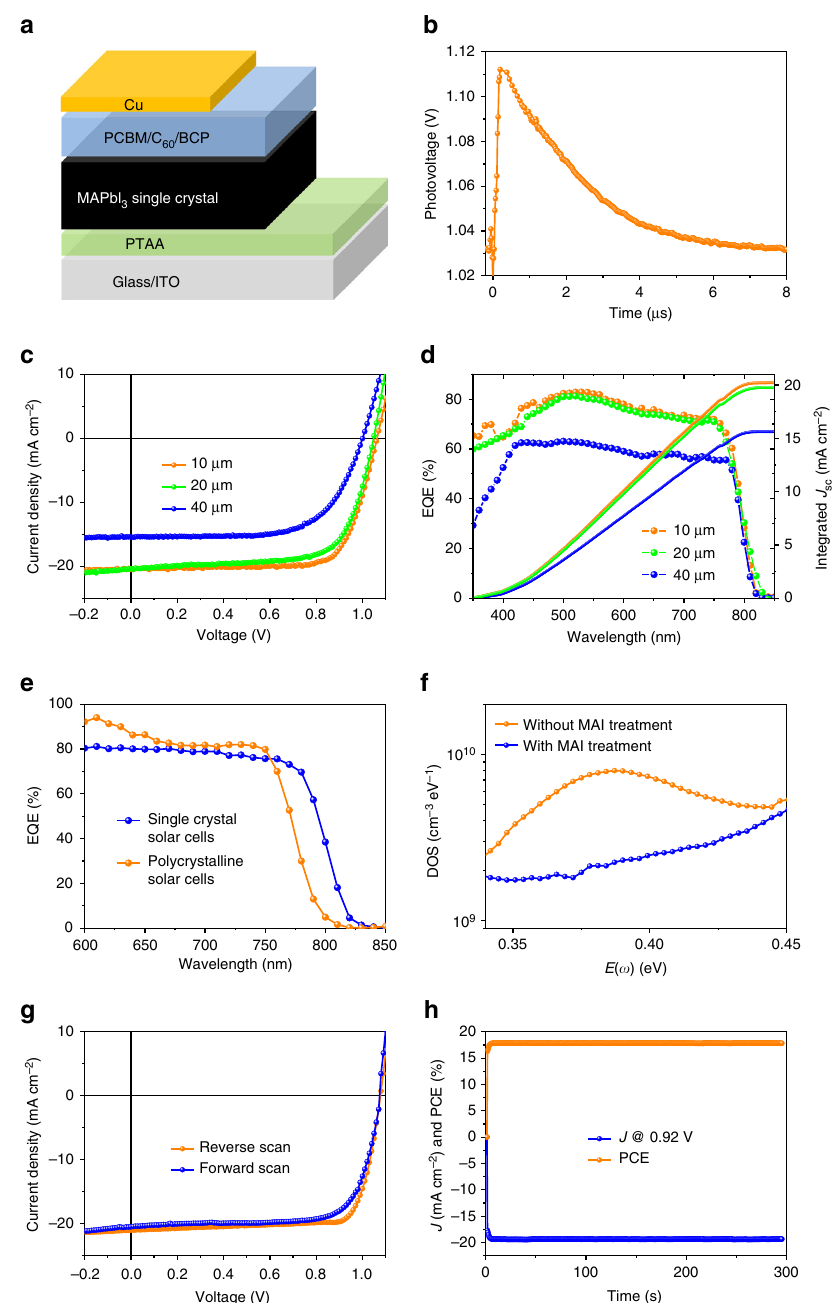
Fig. 4 Characterization of perovskite single-crystal solar cells. a Device structure of the single-crystal solar cells. b Transient photovoltaic curve of a single- crystal solar cell under one-sun illumination. c Current density – voltage and d external quantum ef fi ciency (EQE) curves and integrated current density of the optimal single-crystal solar cells using methylammonium lead triiodide thin single crystal with different thickness. e EQE of single-crystal solar cells and polycrystalline thin- fi lm solar cells. f Trap density of states of the single-crystal solar cells before and after methylammonium iodide (MAI) treatment. g Current density – voltage curves of the single-crystal solar cells after MAI treatment measured under different scanning directions. h Stabilized J sc and PCE of single-crystal solar cells with MAI treatment. The thicknesses of the single crystals in Fig. e – h and polycrystalline thin fi lm are 10 and 500 nm,